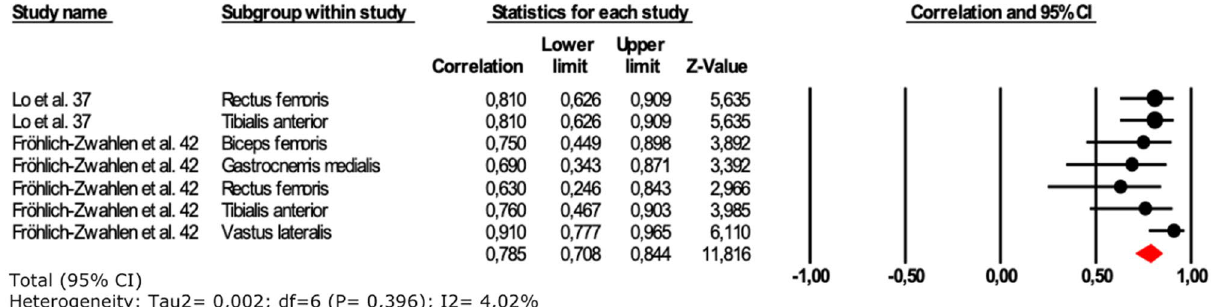
Figure 4. Forest plot of the ICC obtained from intra-rater reliability for lower limbs muscle